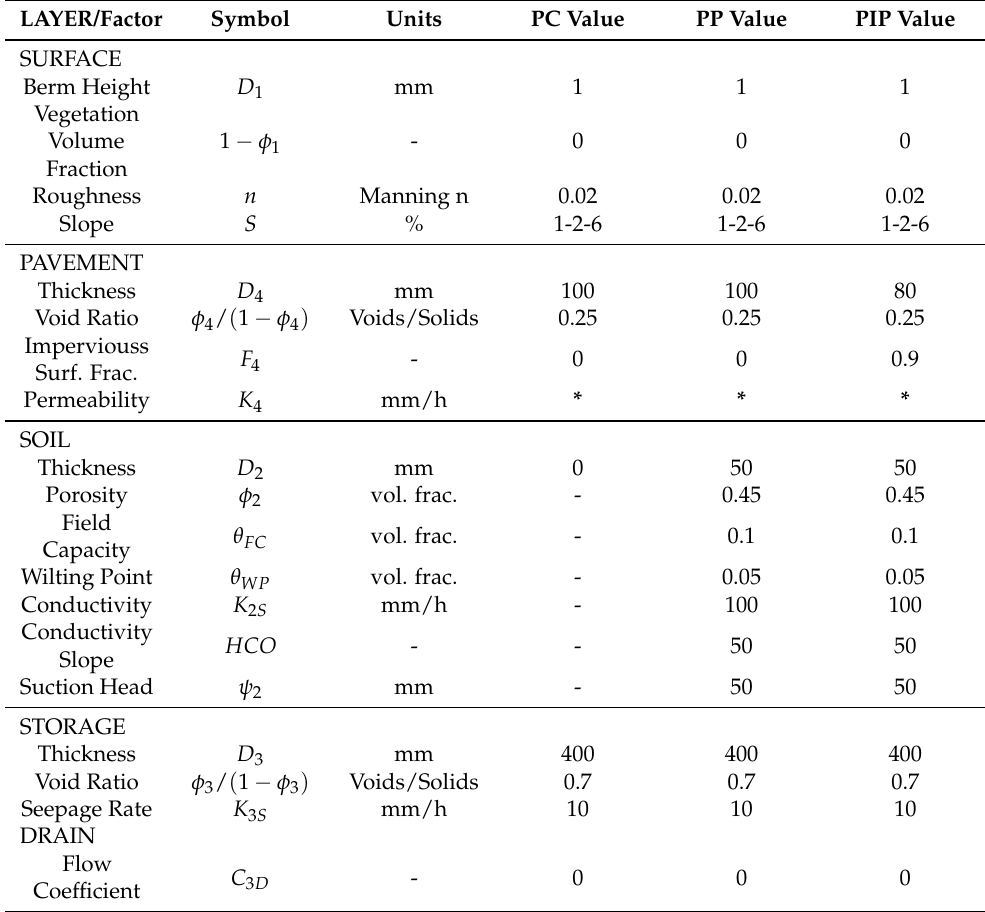
Table 2. SWMM parameters for Permeable Pavement type LID